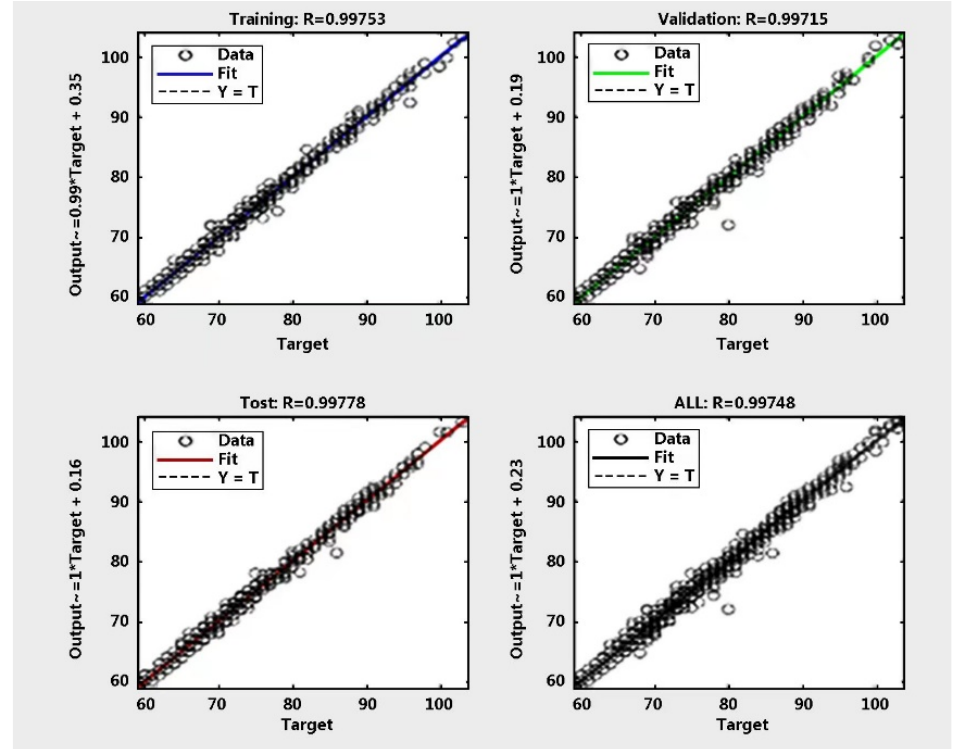
Figure 4. Training regression with R (test 0.997).